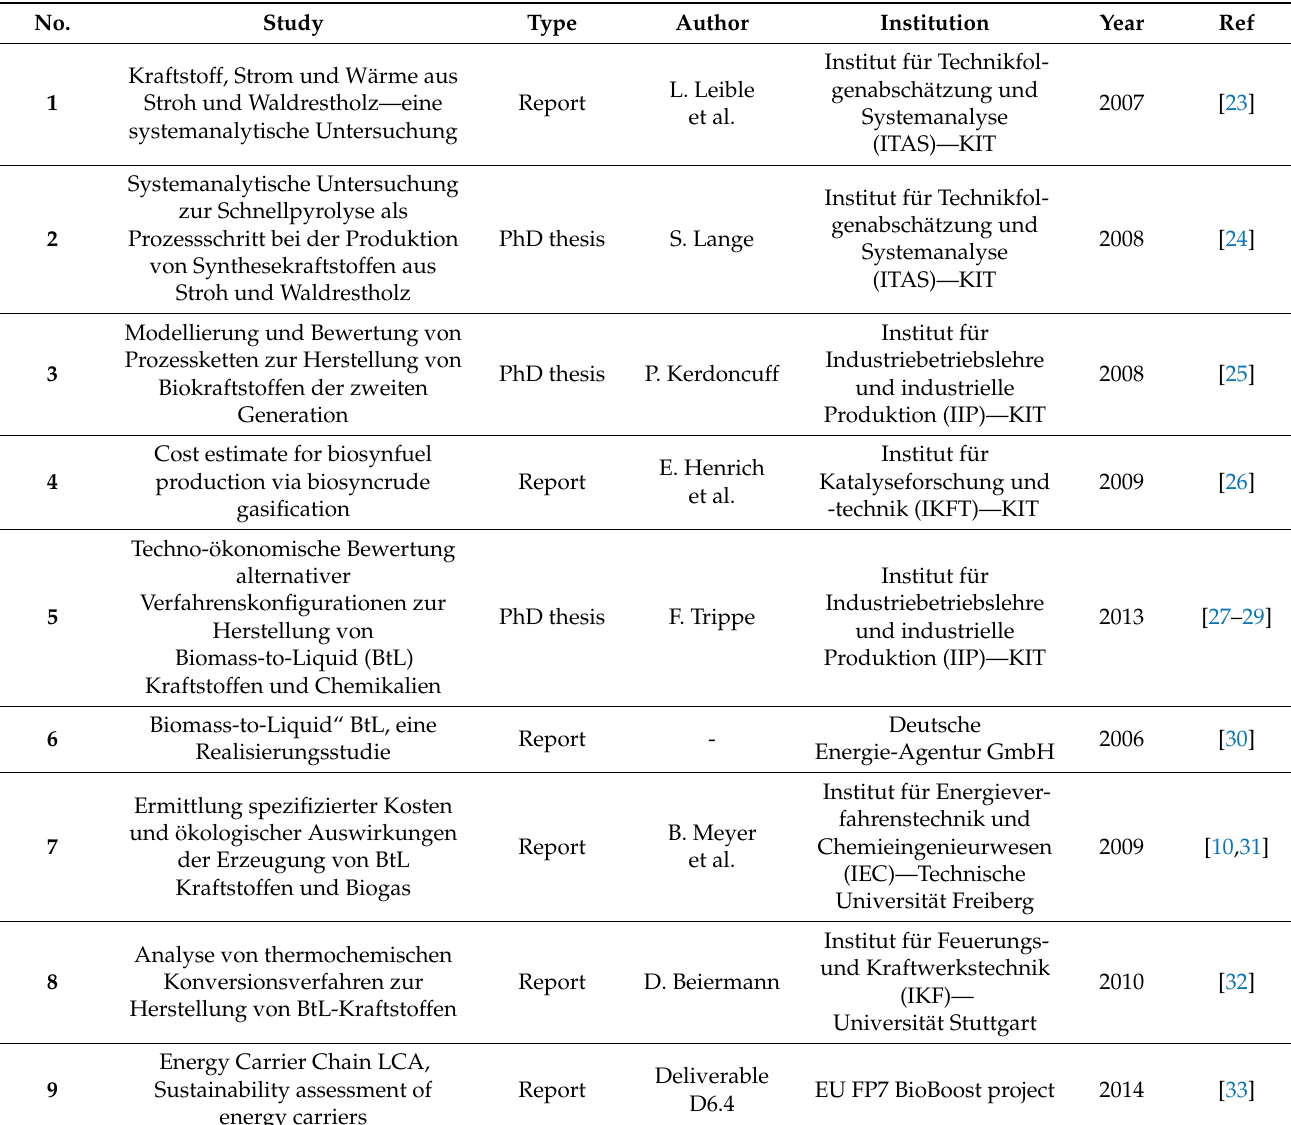
Table 2. Overview on the techno-economic studies investigated in this